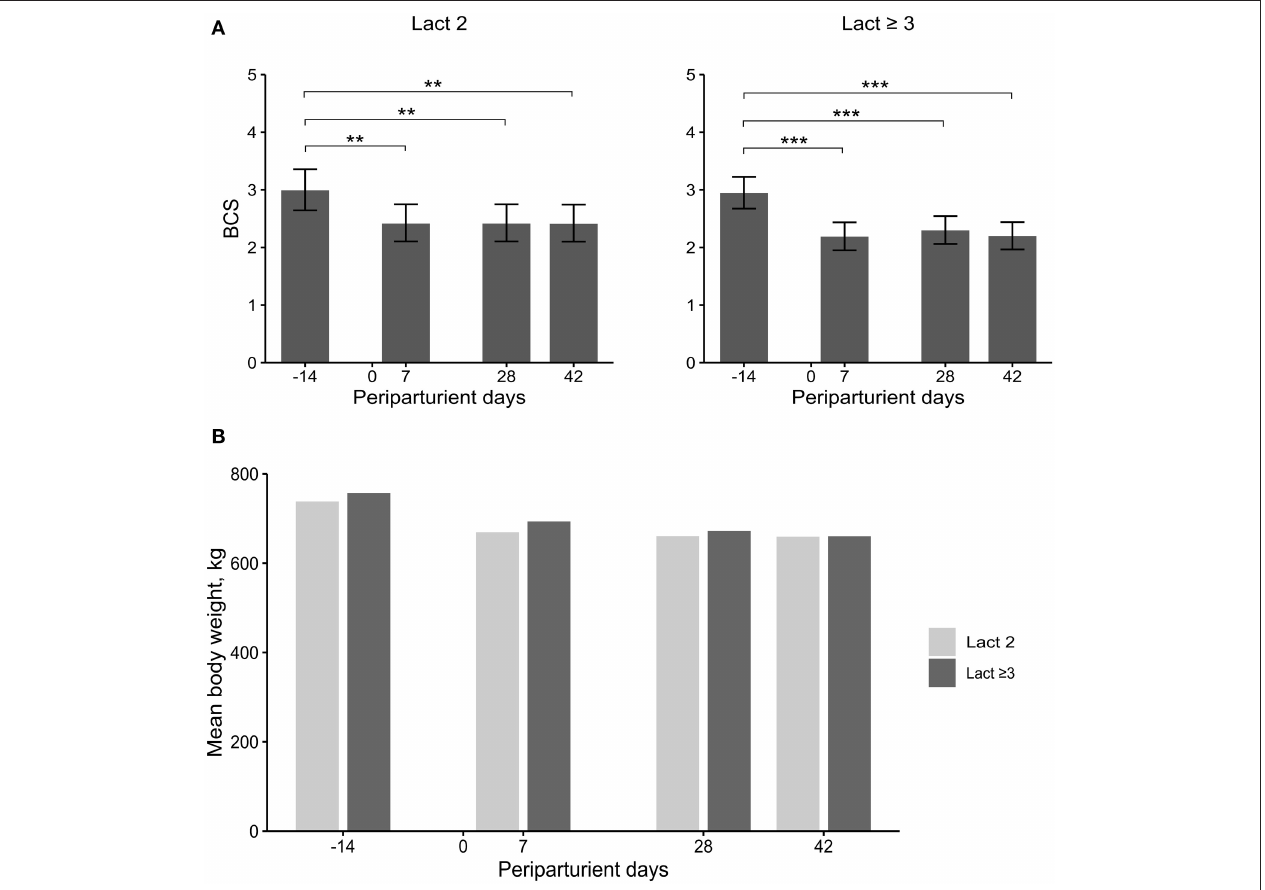
FIGURE 4 | Least square means (LSM) and 95% confidence intervals (error bars) for the body condition score (BCS) (A) and mean body weight (B) at four periparturient sampling days [ − 14 = d 14 antepartum (a.p.); 0 = parturition; 7, 28, 42 = d 7, d 28, d 42 postpartum (p.p.)] in two groups (Lact2 = lactation 2, n = 3; Lact ≥ 3 = lactation 3 or greater, n = 5) of German Holstein cows. Significances between sampling days within groups ( P -values F-test): BCS: Lact2: P < 0.01 , Lact ≥ 3: P < 0.01 ; mean BW: d 14a.p.: ( P = 0.42 ), d 7 p.p.: ( P = 0.32 ), d 28 p.p.: P = 0.50 , d 42 p.p.: ( P = 0.78 ). Significant changes over time are marked with asterisks (** P < 0.01 , *** P < 0.001